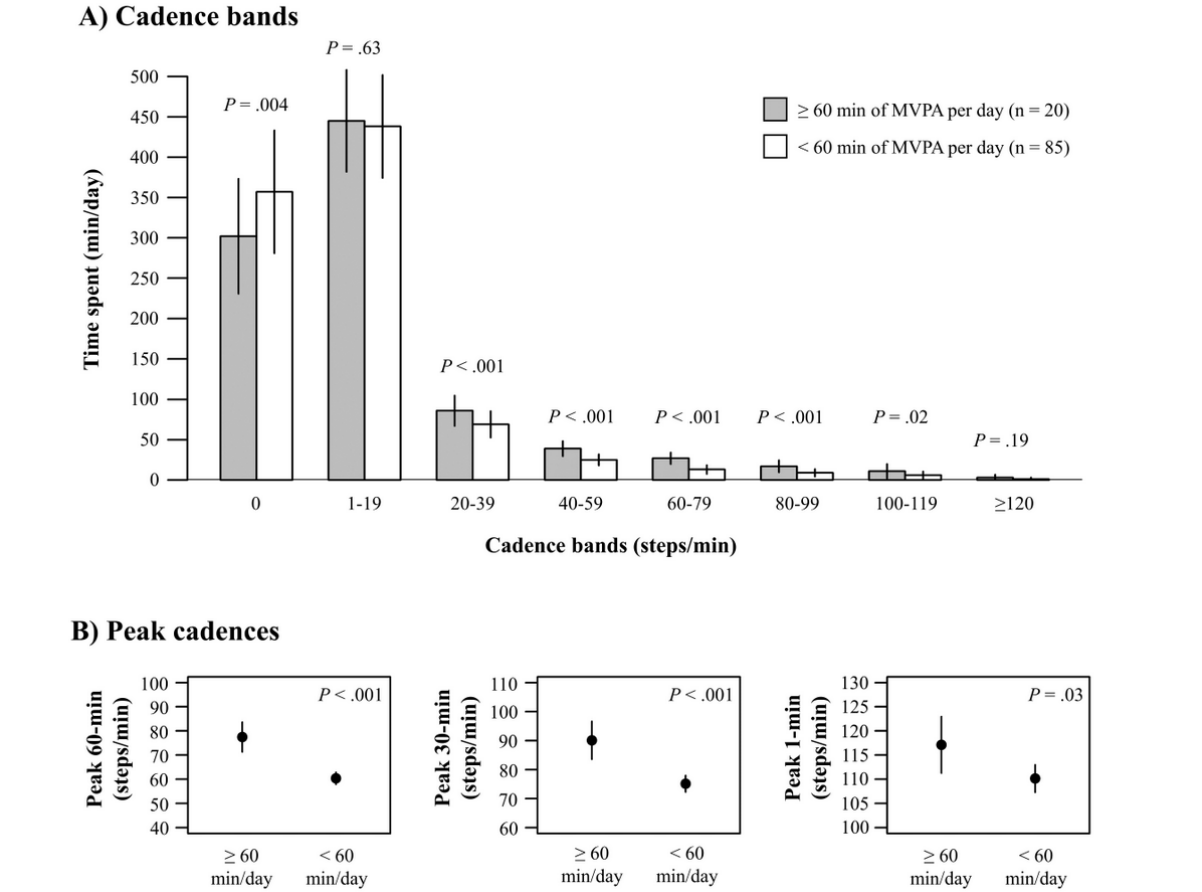
Figure 3. Time spent in each cadence band (panel A) and peak cadences (panel B) across children meeting or not meeting the physical activity guidelines (ie, ≥ 60 minutes of MVPA/day). Error bars represent SDs. MVPA: moderate-to-vigorous physical